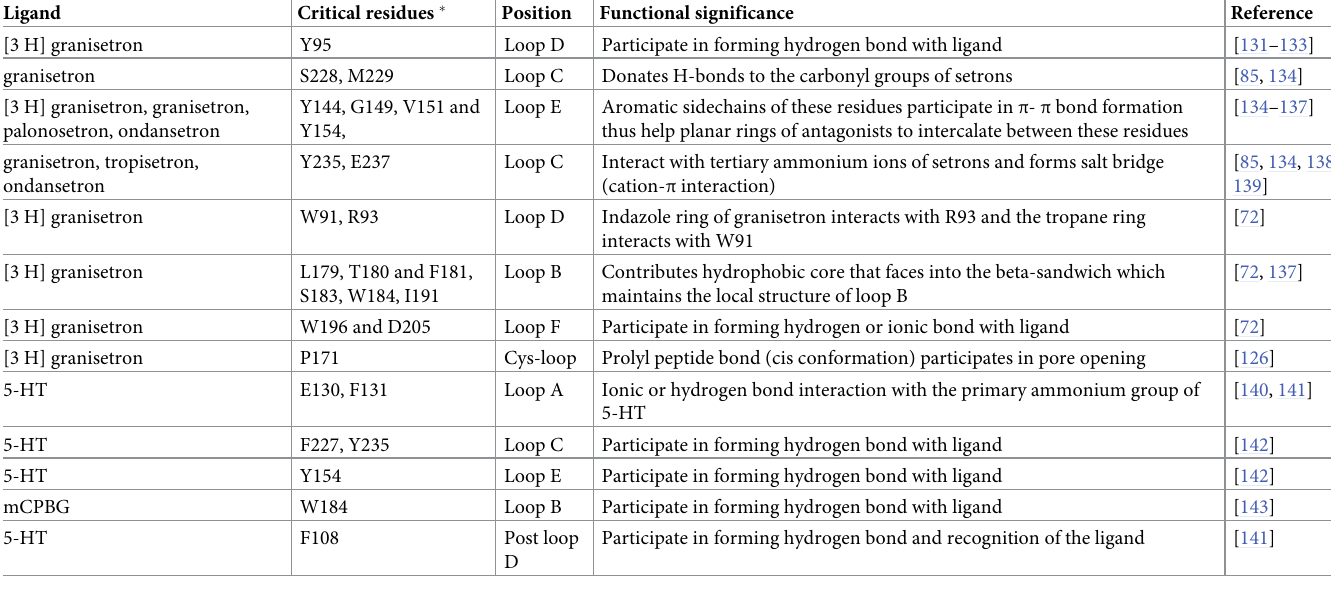
Table 2. Human 5HT3A subunit (AAP35868.1) extracellular domain amino acid residues that participate in functional activity of the receptor. Ligand Critical residues � Position